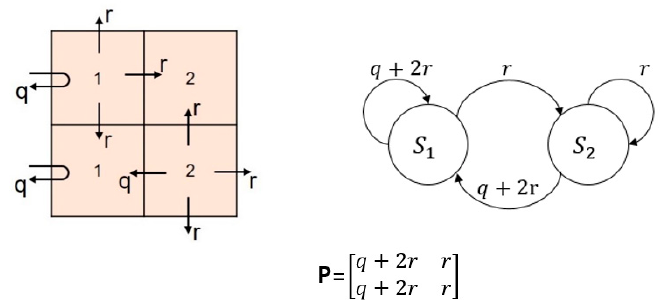
Figure 7. State transition diagram and state transition matrix ( n = 4).